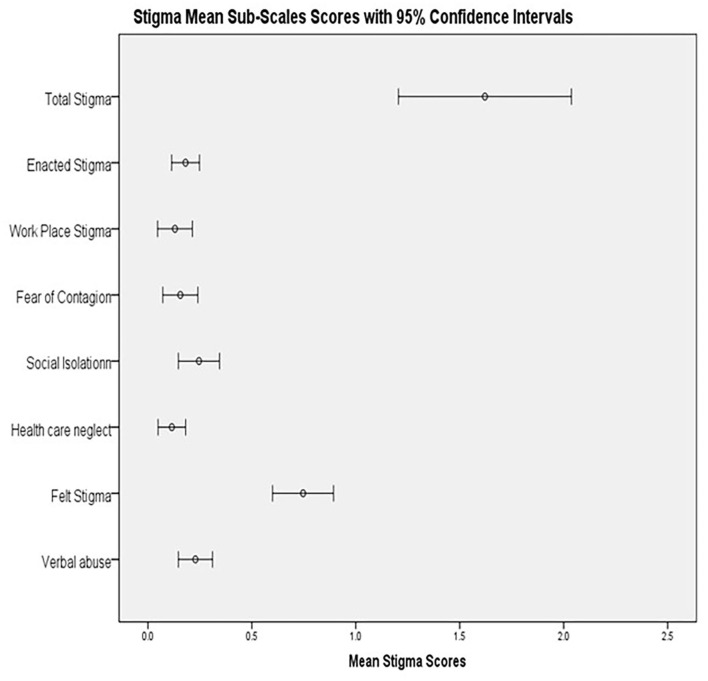
Mean subscales HIV-related stigma scores with 95% CI.